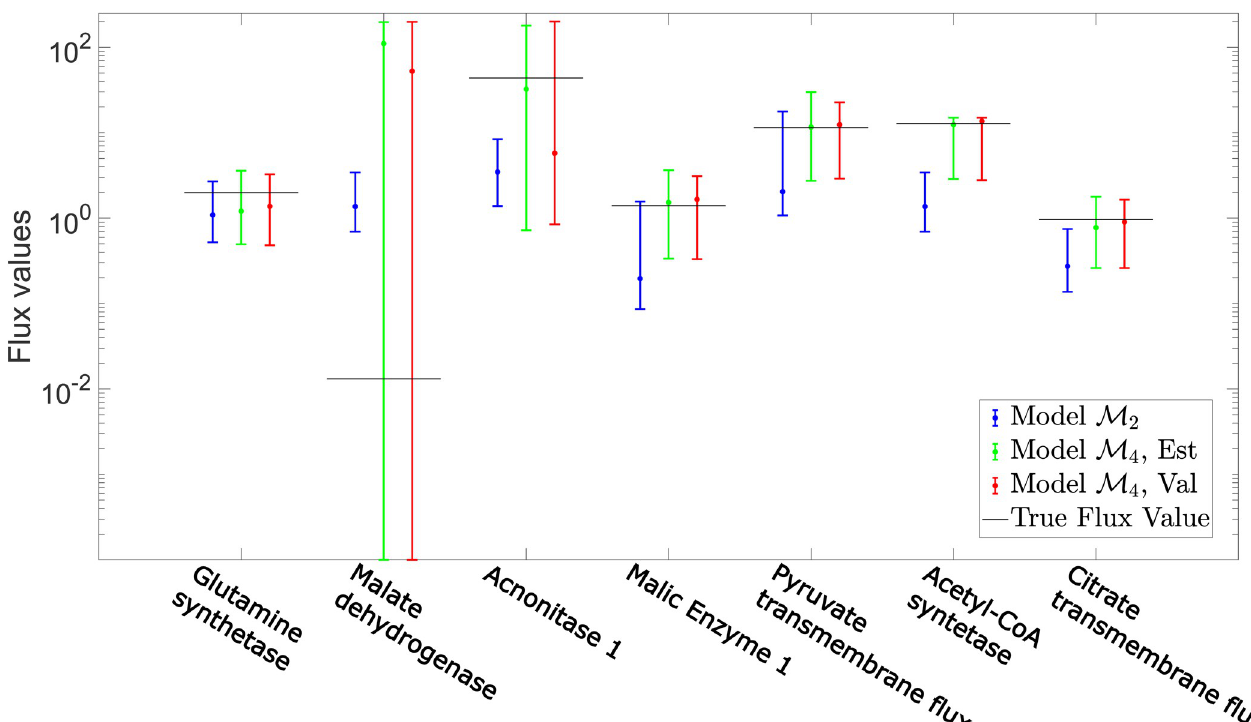
Fig 9. Comparison of estimated flux solutions for the simulated 13 C MFA example. The resulting flux values with 95% confidence intervals for seven of the fluxes that are overlapping between all model structures in the simulated 13 C MFA example. The confidence intervals correspond to the estimated fluxes for model M (Blue), model M with all data available (Green) and model M with the data split into D est and D val (Red). The figure illustrates the selecting the 2 4 4 wrong model structure may result in incorrect flux